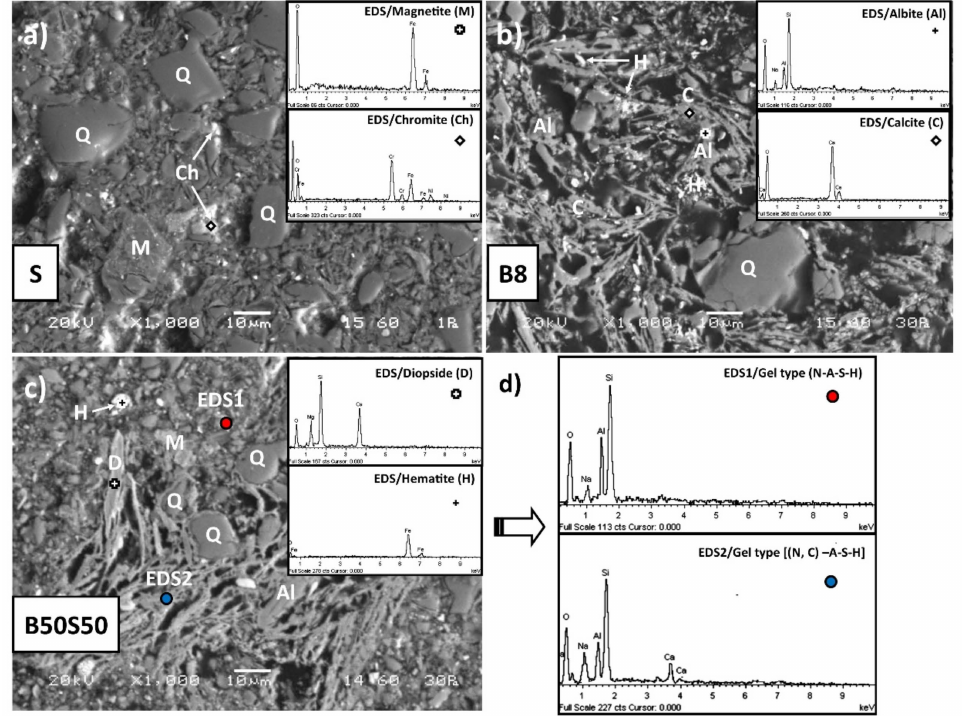
Figure 7. Back-scattered electron images of selected IPs produced with ( a ) metallurgical slag (S), ( b ) brick waste (B8) and ( c ) B50S50 IP specimen. The presence of unreacted minerals is seen in